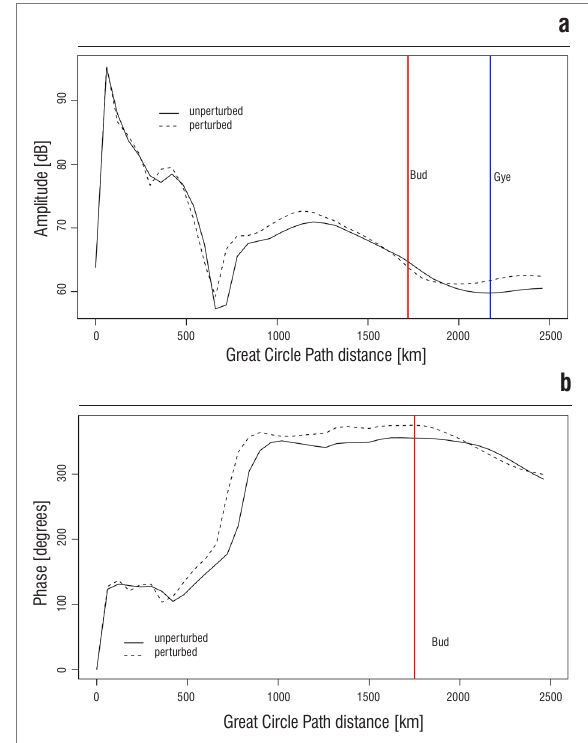
shows the modal minima moving towards the transmitter from 500 km to 440 km and a phase advance at the Budapest receiver.